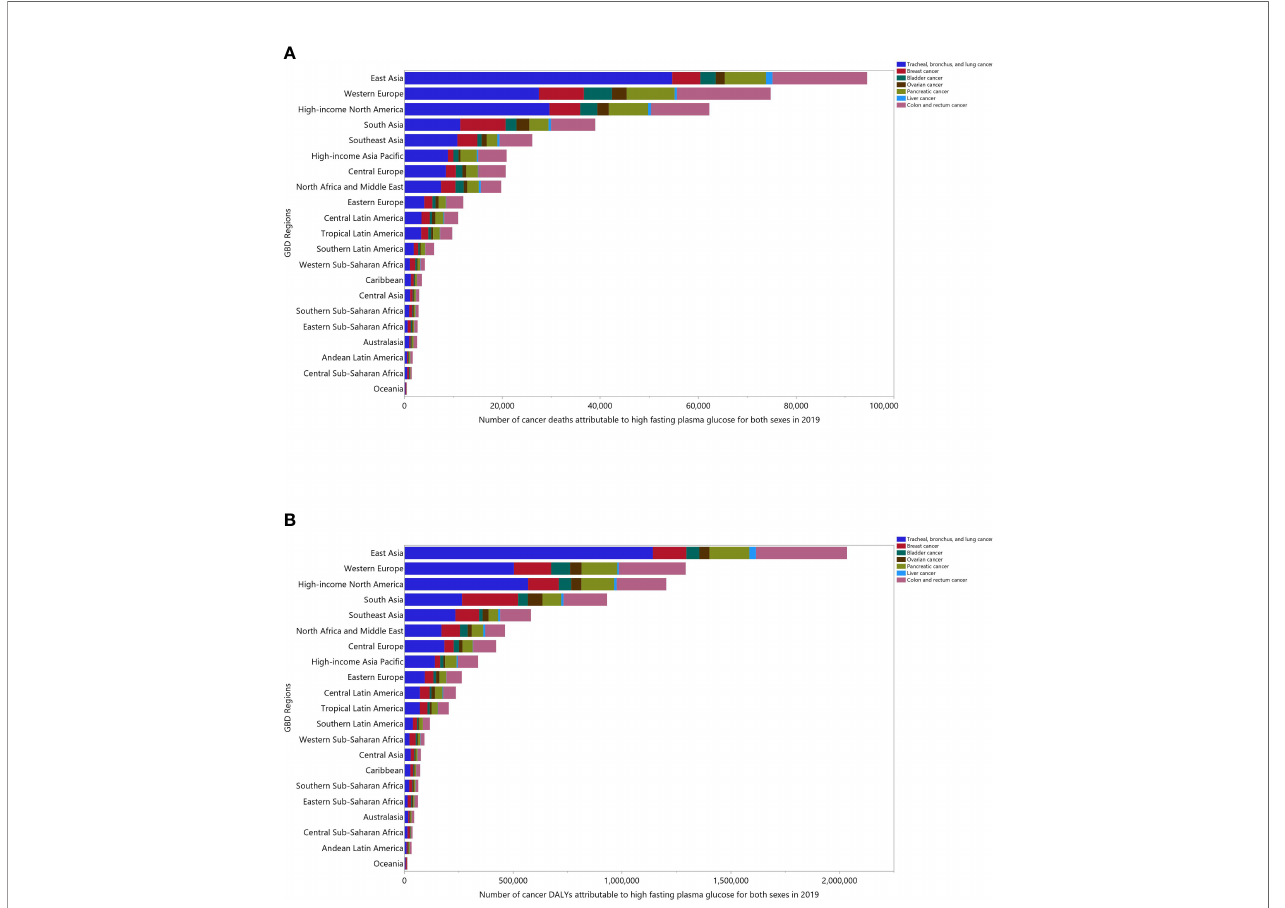
FIGURE 1 | Number of cancer deaths (A) and DALYs (B) attributable to high fasting plasma glucose in 2019 by cancer types and GBD region. DALY= disability- adjusted-life-years (Generated from data available from